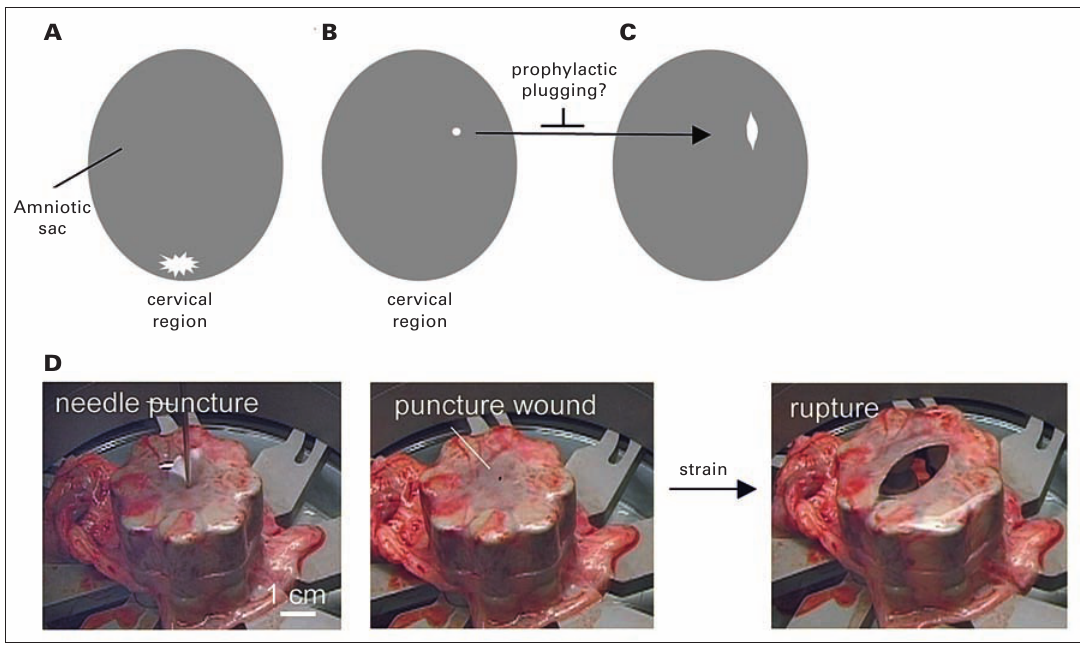
Characteristics of foetal membrane wounds on current evidence. (A) Spontaneous membrane ruptures seem to occur at a predefined, natural breaking site in the cervical region of the foetal membranes [4]. Spontaneous ruptures are poorly demarcated wounds in the several-centimeter range. (B, C) Iatrogenic wounds. (B) Foetoscopic access leads to small-sized wounds in the few-millimeter range in foetal membranes. The wound site is only known at the time of the intervention. (C) Rupture from iatrogenic puncture. According to [5], iatrogenic ruptures may be more cleanly delineated than spontaneous ruptures. Prophylactic plugging of foetoscopic access sites may inhibit membrane leakage iatrogenic rupture. (D) Ex vivo simulation of iatrogenic rupture from puncture. A needle puncture wound of 1.4 mm diameter was created in fresh foetal membranes collected from a term pregnancy. Upon mechanical stretching, the foetal membranes rupture from the site of the puncture. A cleanly delineated wound of several centimeters in